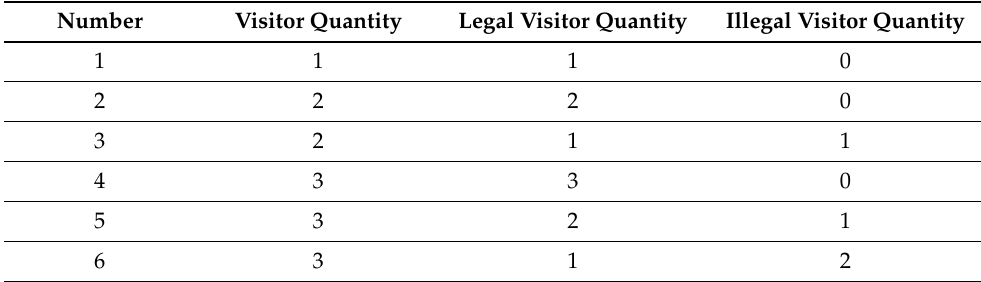
Table 1. Experimental setup of tailgating intrusion